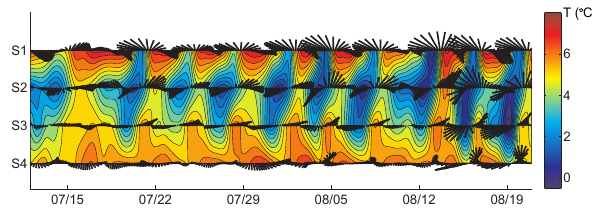
Figure 11. Hovmöller diagram of temperature ( ◦ C) and velocity anomalies at 80mab across mooring section S. Temperature scale bar on the